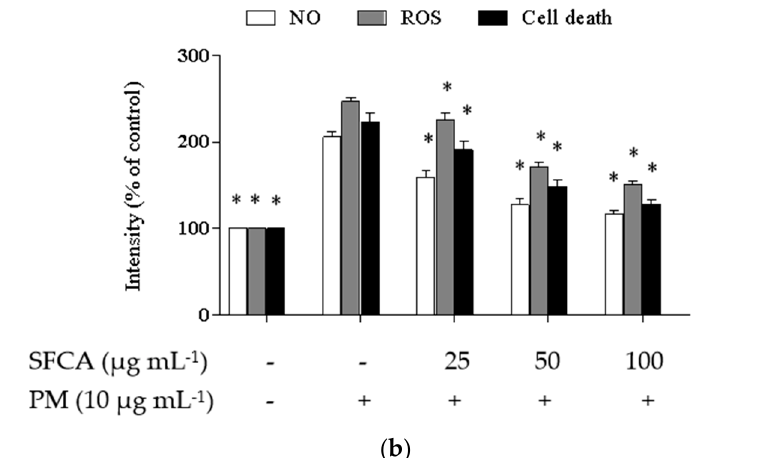
Figure 5. Inflammatory stimulation of zebrafish larvae by PM and anti-inflammatory effects of SFCA: ( a ) anti-inflammatory properties were evaluated by measuring NO and ROS production, and cell death in the zebrafish embryo model and ( b ) their intensities. Experiments were carried out in triplicate, and the results are represented as means ± SE. Values are significantly different from the positive control (PM treated group) at * p < 0.05.